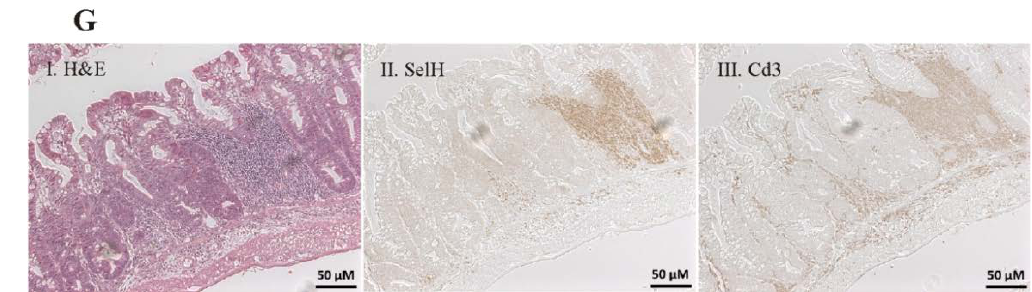
Figure 7. Colonic selenium status is replete after short-term supplementation with SeMet and selenite. Total ( A ) GPx and ( B ) TrxR activity was measured in homogenates of the colon. Data are shown as the mean + SD. n = 12. Colonic mRNA expression of ( C ) Selh, ( D ) Selw1, ( E ) Gpx1 and ( F ) Sepp1 was measured by qPCR and normalized to Rpl13a. Each point represents one mouse. Lines indicate means. Significant differences were calculated by one-way ANOVA and Bonferroni’s posttest. * p < 0.05, ** p < 0.01, *** p < 0.001 vs. − Se; + p < 0.05 vs. ++ SeMet 7 days. ( G ) Colon Swiss rolls were